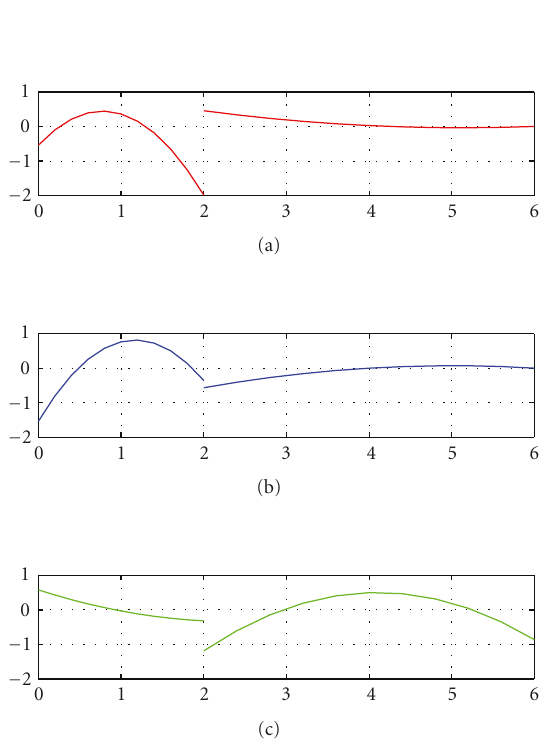
Figure 9: Orthonormal quadratic wavelet basis (one continuity